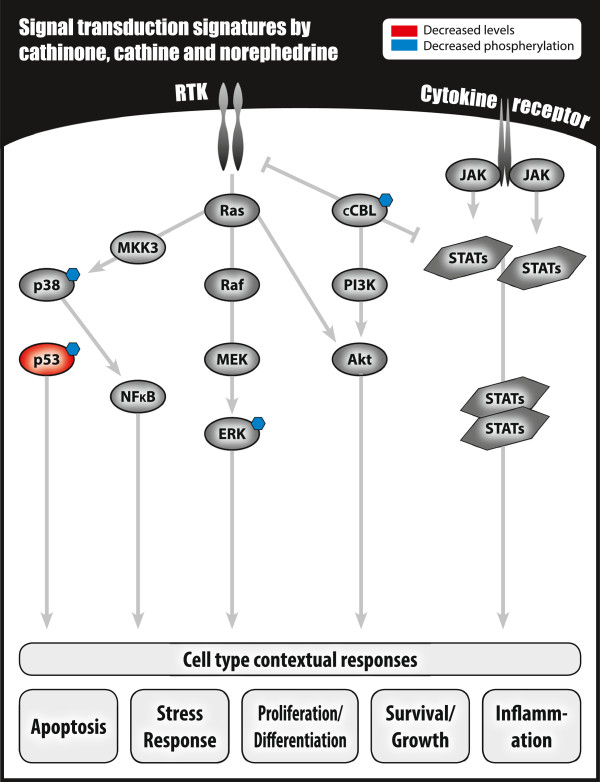
A summary of our present findings of cell signal transduction signatures in leukocytes stimulated with amphetamine-like cathinone, cathine or norephedrine.